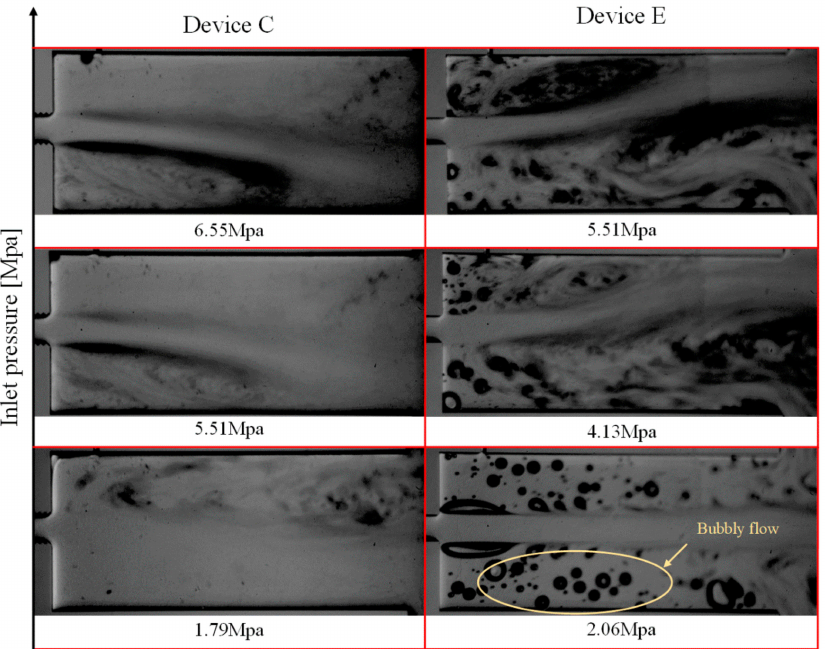
Figure 8. Cavitation flow patterns for devices C and E (worst cases in the previous phase) working with